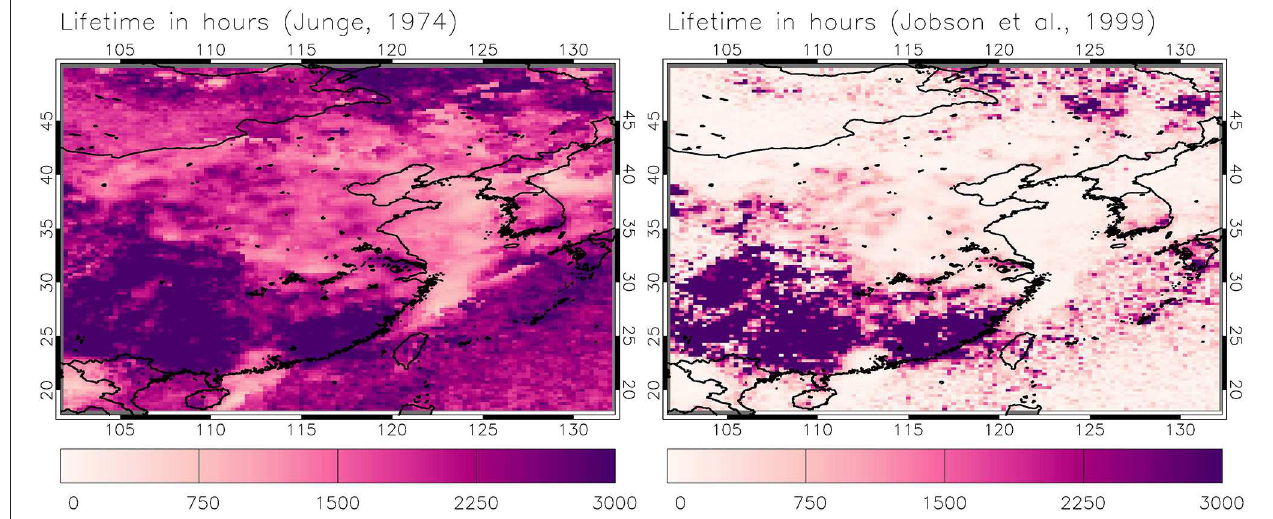
FIGURE 1 | Left : NO 2 lifetime τ for 2007 calculated from τ = 0.14 [NO 2mean ]/ σ [NO 2 ], where [NO 2mean ] is the average yearly OMI Tropospheric NO 2 column (in 10 15 molec/cm 2 ) and σ [NO 2 ] is the standard deviation of the daily values. Right : NO 2 lifetime τ for 2007 calculated from the σ (ln[NO 2 ]) = τ − 0.18 equation. The map axes are in degrees Eastern longitude/Northern latitude.